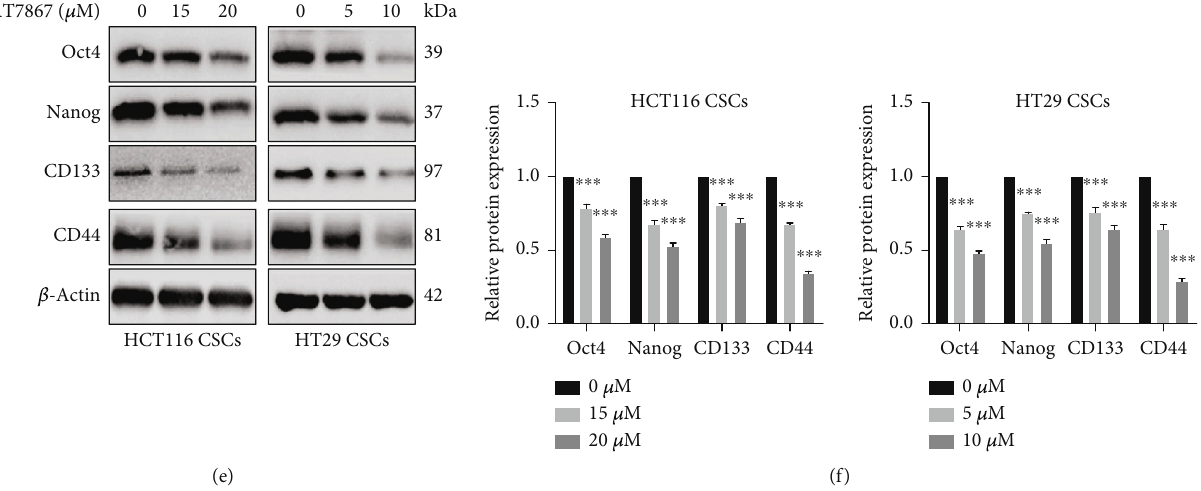
Figure 2: AT7867 inhibits the growth and stemness of CSCs. (a, b) By being cocultured with AT7867 for 1 to 3 days, cell viability was measured by performing CCK-8 assay. (c, d) Representative morphology after AT7867 treatment (sphere formation assay) or pretreatment (sphere recovery assay); Scale bar 200 μ m. (e, f) Oct4, Nanog, CD133, and CD44 protein levels were measured by performing Western blot. ∗ P < 0 : 05 , ∗∗ P < 0 : 01 , and ∗∗∗ P < 0 : 001 vs. the